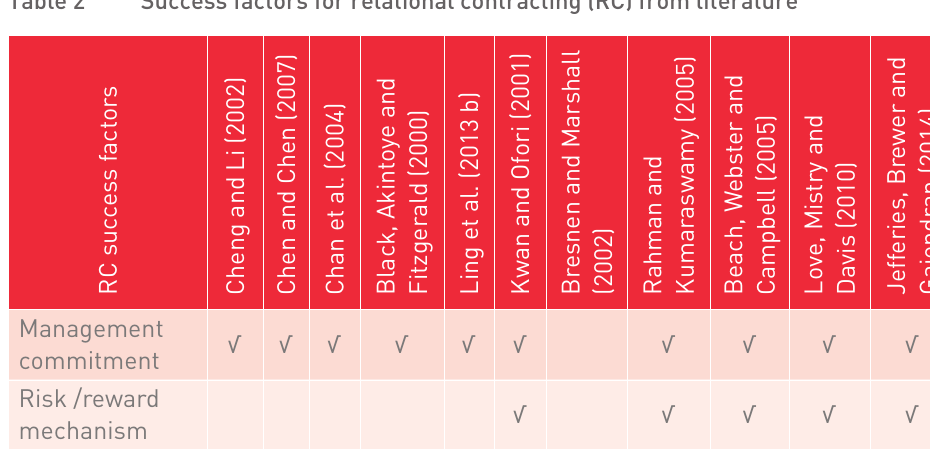
Success factors for relational contracting (RC) from